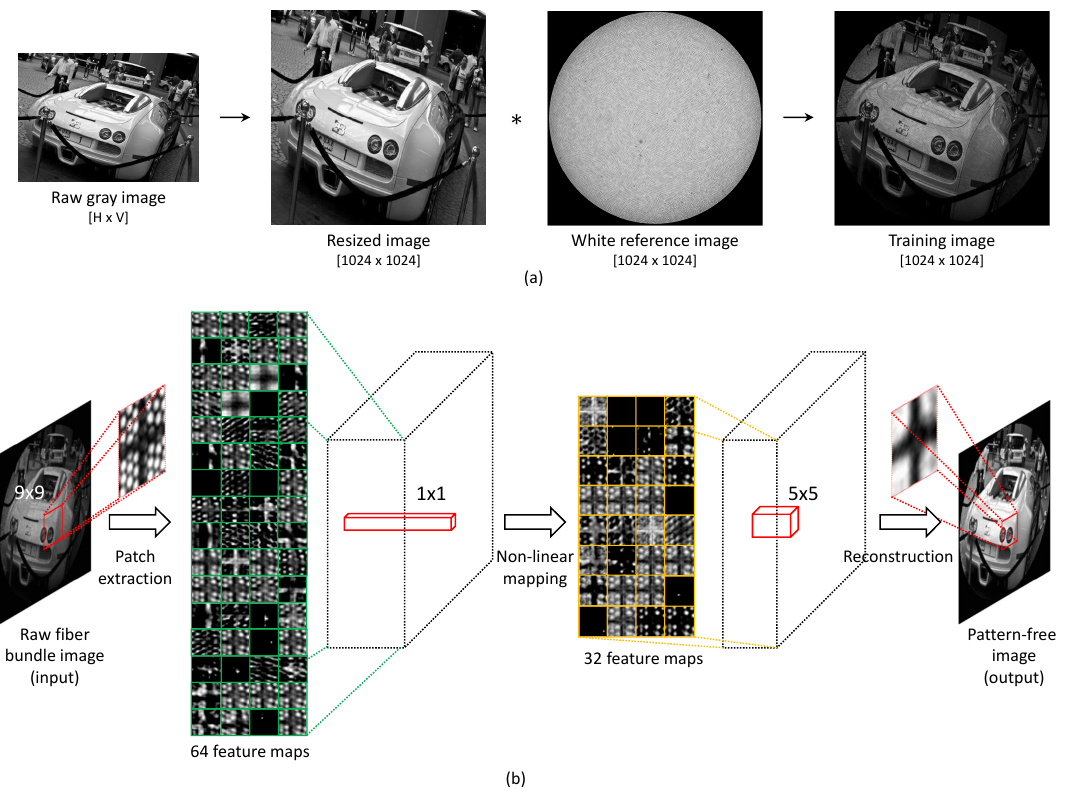
Figure 2. ( a ) Sequence of the training dataset generation via honeycomb pattern synthesis on ordinary images. ( b ) Network architecture of HAR-CNN with three convolution layers for patch extraction, nonlinear mapping, and reconstruction